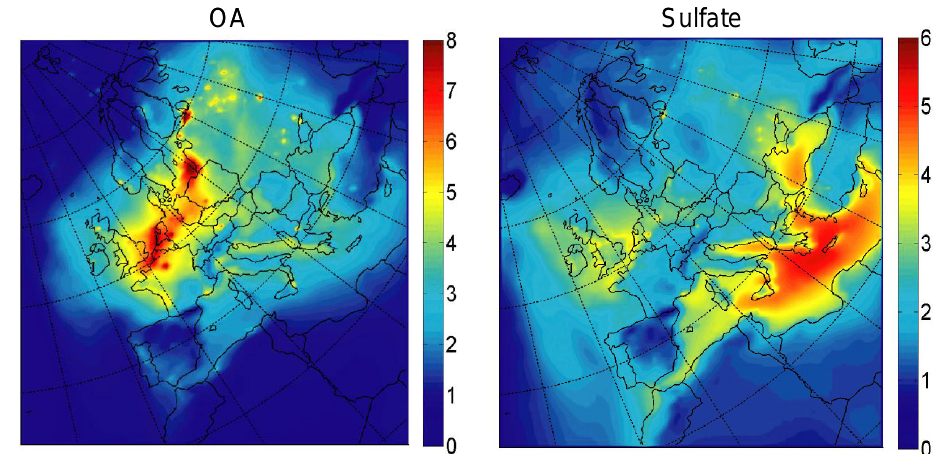
Fig. 19. Ground-level concentration predictions averaged over the entire simulation period (1–29 May 2008) for PM 2 . 5 total organic aerosol and sulphate (in µgm − 3 ). Different scales are